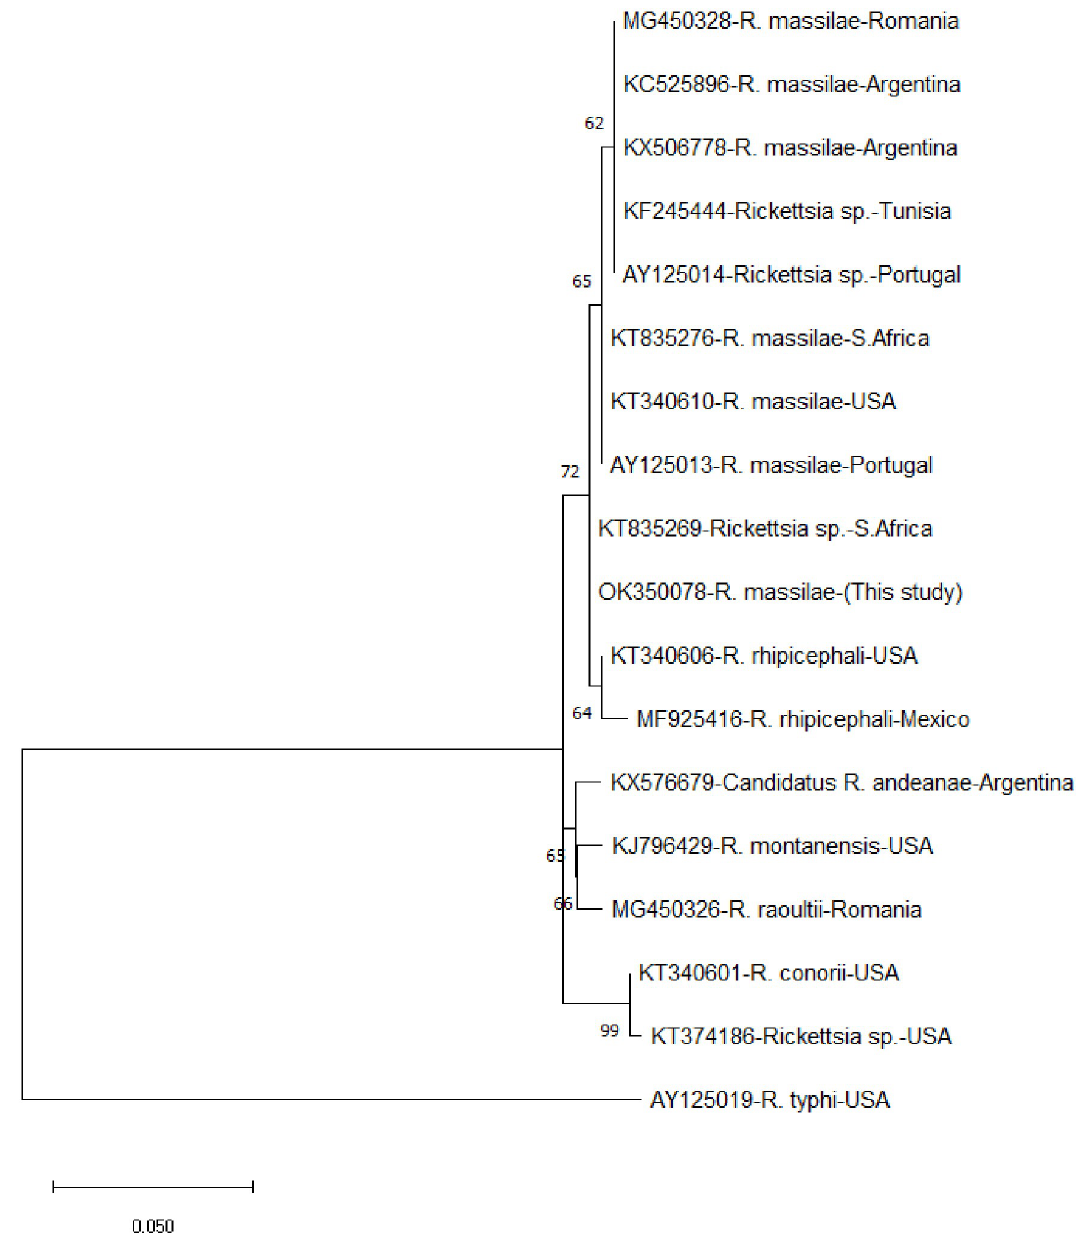
Fig 1. Molecular phylogenetic analysis inferred by Maximum Likelihood of Rickettsia massiliae based on the 350bp partial 23S- 5S IGS sequences of Rickettsia species taken from the NCBI database and sequence amplified from Rhipicephalus species tick collected from Nigerian small